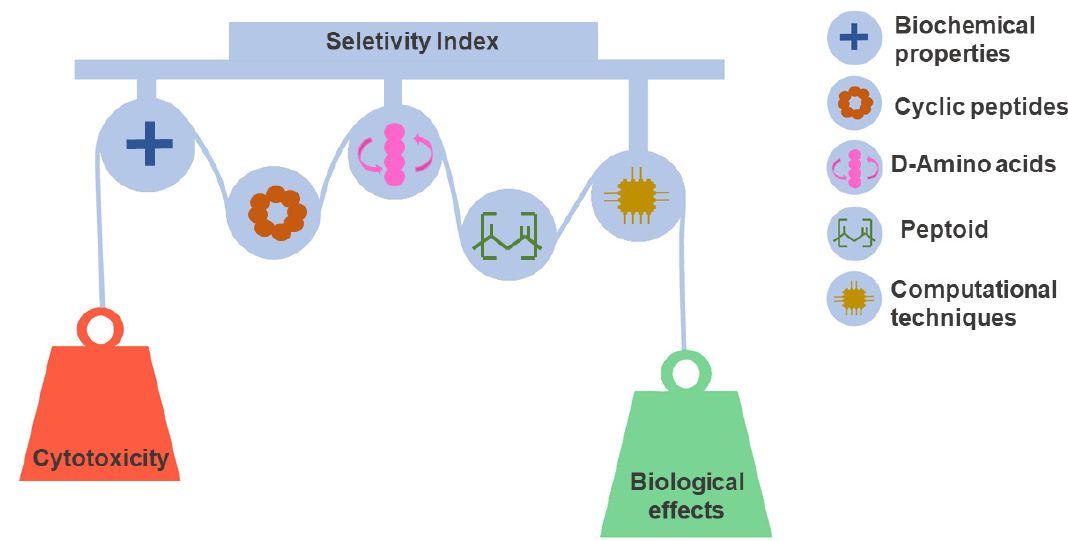
Figure 4. Peptide selectivity optimization strategies. Selectivity is a favorable characteristic of considerable significance for the success rate of drug candidates. However, selectivity optimization is a complex task that must balance the properties that govern toxic and therapeutic effects. Different design and synthesis strategies have contributed to this objective. In the design step, the evaluation of physicochemical properties and SAR relationships integrated with computational techniques play a decisive role in peptide selection. In the same context, cyclization, use of D amino acids, and peptidomimetics have been key for the development of stable and selective